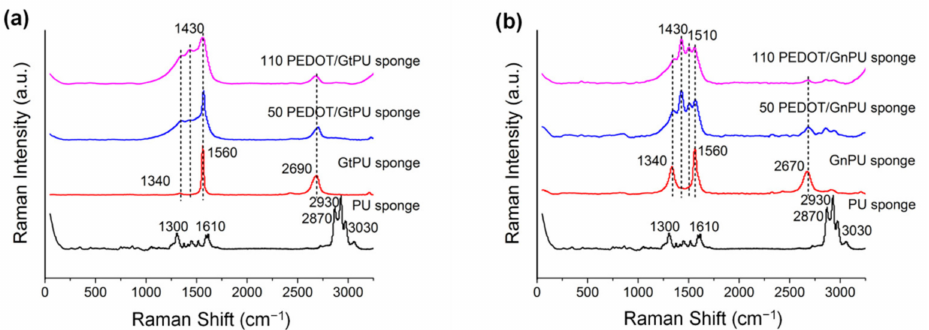
Figure 2. ( a ) Raman spectra of PU, GtPU, 50 PEDOT/GtPU and 110 PEDOT/GtPU sponge. ( b ) Raman spectra of PU, GnPU, 50 PEDOT/GnPU and 110 PEDOT/GnPU sponge.